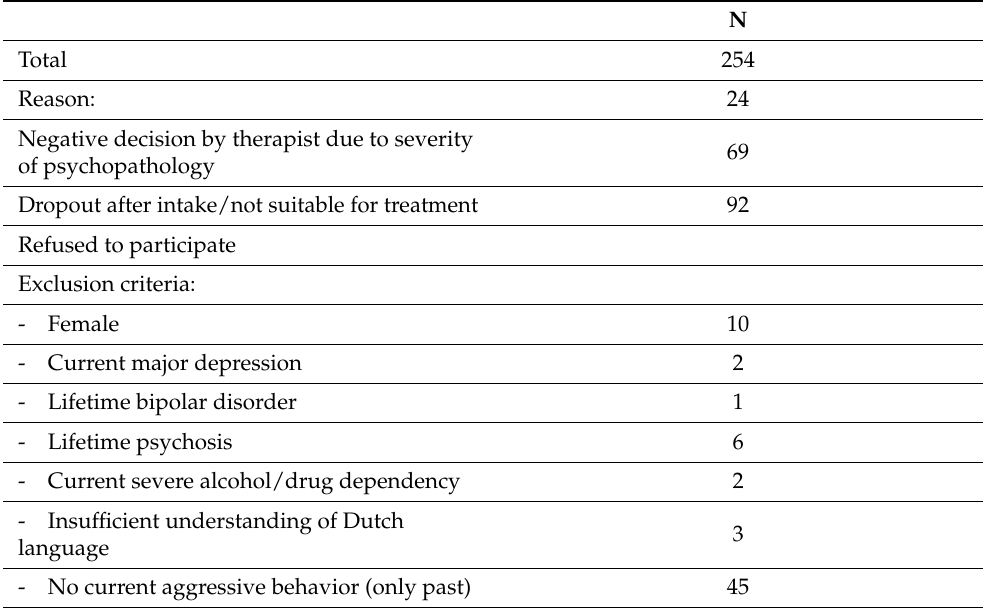
Table 1. Reasons for exclusion.